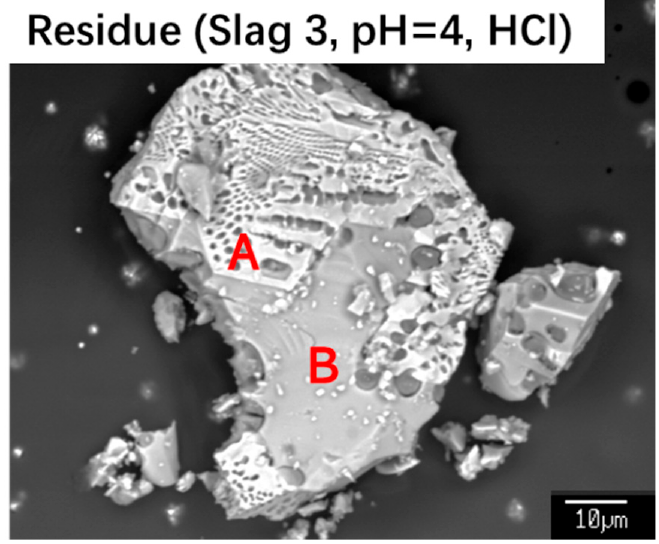
Figure 10. XRD patterns of slag 3 and its residue after leaching in hydrochloric acid solution at pH 4.